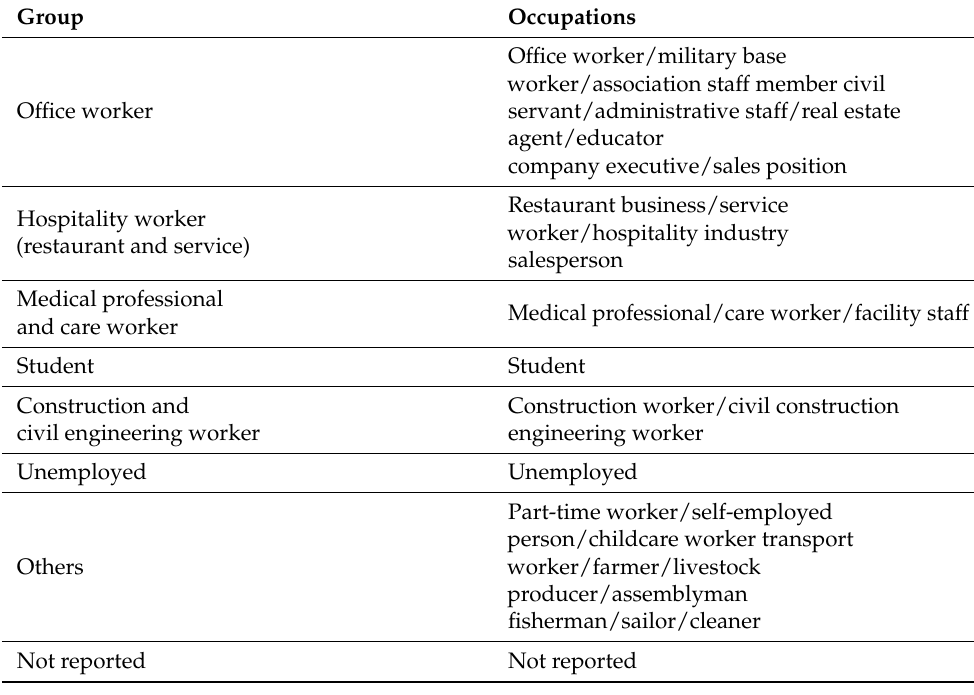
Table A2. Detailed description of occupation